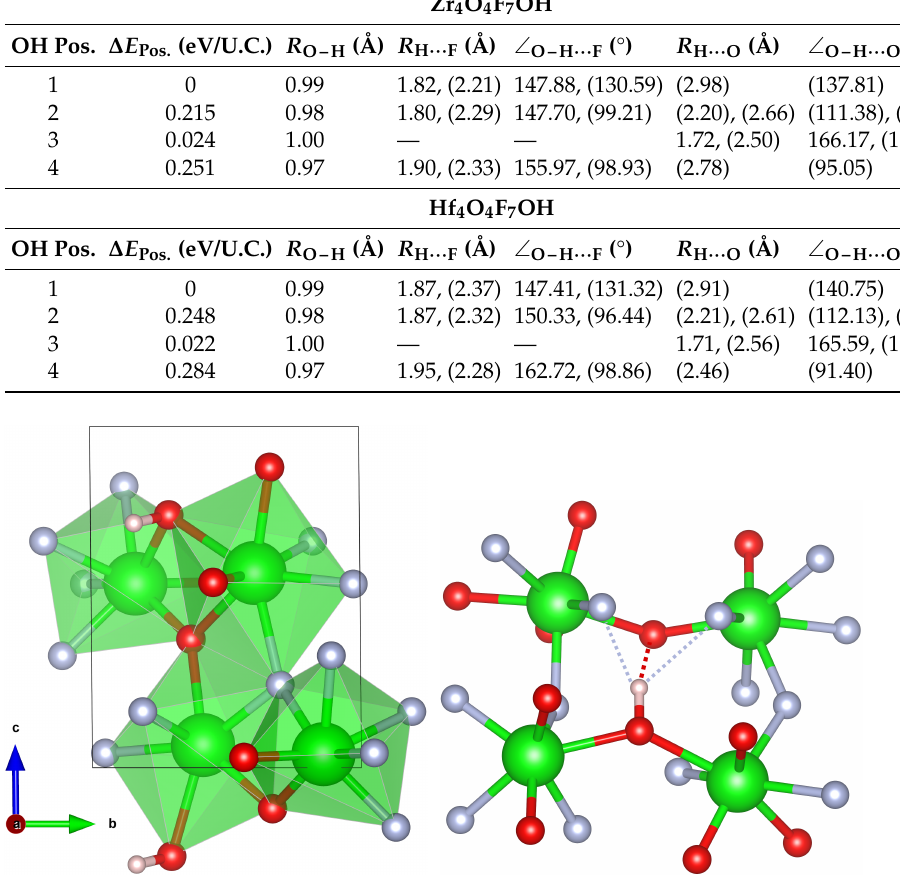
Figure 5. Relaxed unit cell of the most stable Zr 4 O 4 F 7 OH structure obtained by the mono- hydroxylation at position 1 ( left ). The M 4 O 4 F 7 OH structure looks practically equivalent to the Zr-species. The unit cell parameters are given in Table 3. The structural insert ( right ) shows the trifurcated H-bond with three components (dashes). The structural H-bond data is listed in Table